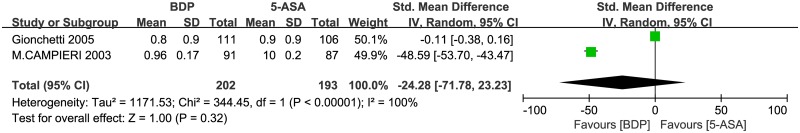
Forest plot of randomized controlled trials of BDP vs. 5-ASA in inducing Reduction of DAI parameters: intestinal mucosa, in ulcerative colitis.BDP, beclomethasone dipropionate. 5-ASA, mesalazine. M-H, Mantel-Haenszel.